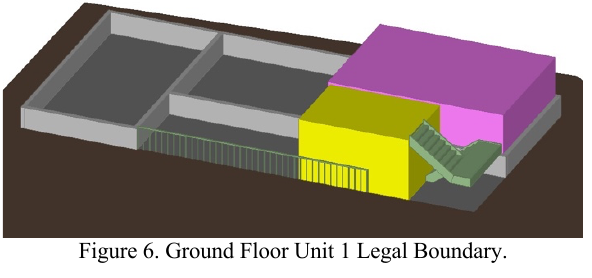
Figure 6. Ground Floor Unit 1 Legal Boundary.